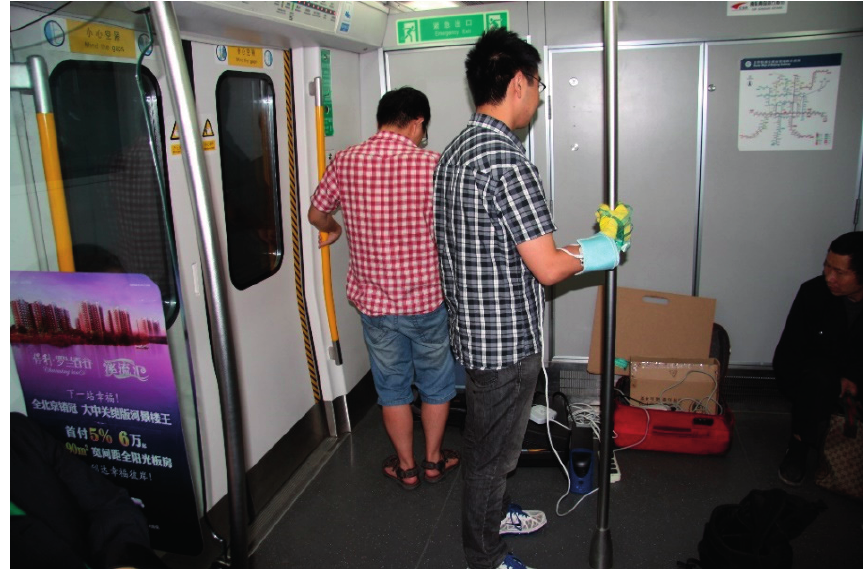
Figure 11. Field test